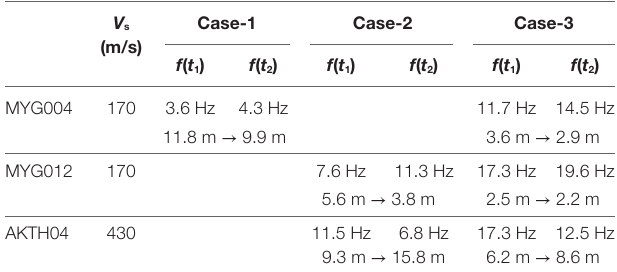
Table 7 | Modulation of dominant frequency in non-stationary Fourier spectra. V s (m/s)